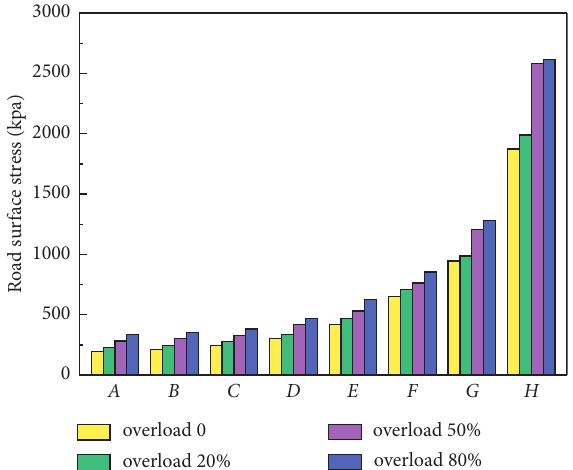
Figure 15: Impact of vehicle overload condition on road surface stress (A ∼ H).